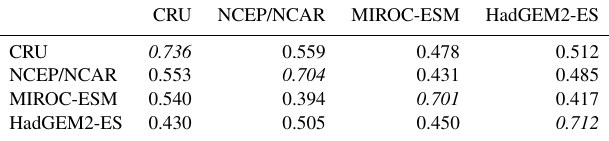
Table 1. CNN model accuracies for biome distribution simulations. These accuracies were obtained using the model trained by the cli- matic dataset on the row, with the climate dataset on the column as an input reconstruction. Therefore, the italic values show the accu- racy when the climate datasets for training and reconstruction were identical. For each climate dataset, the monthly mean temperature and monthly precipitation during 1971 to 1980 were standardized and log transformed, then used for drawing the RGB colour tile